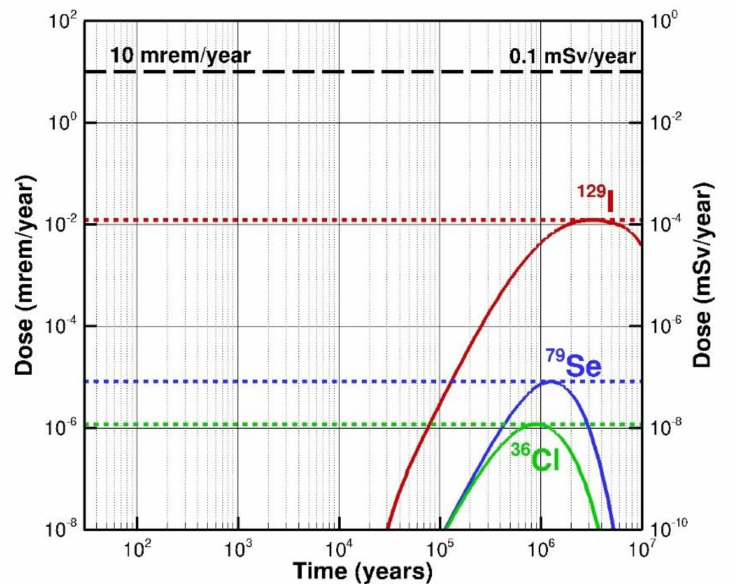
Figure 5. Annual dose curves for reference scenario. Dose contributions from 99 Tc, 245 Cm, 241 Am, 237 Np, 233 U, and 229 Th are insignificant. The cumulative dose curve from all considered radionuclides is indistinguishable from that of 129